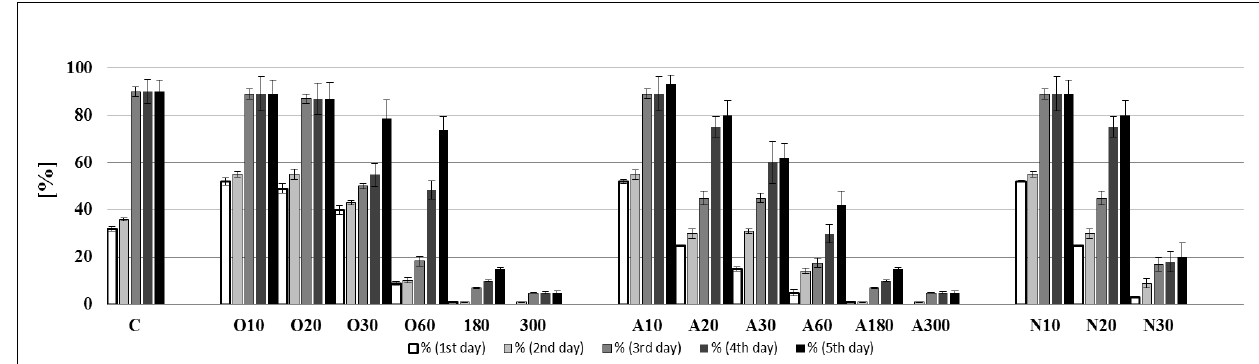
Figure 2. The dynamics of barley grain germination represented by calculated Percentage of Germination (%) on 1st, 2nd, 3rd, 4th and 5th day of cultivation. Variants: C—control/untreated barley grains; O10–O300: barley grains treated with plasma generated in an oxygen atmosphere for 10, 20, 30, 60, 180 or 300 s; A10–A300: barley grains treated with plasma generated in ambient air for 10, 20, 30, 60, 180 or 300 s; N10–N300 barley grains treated with plasma generated in a nitrogen atmosphere for 10, 20, 30, 60, 180 or 300 s. Bars are means of ten experimental runs (one run represents 50 grains per variant, n = 500) ± SD. Table 1. Shoot and root length/weight and adventitious root number of 5-day-old barley seedlings after CAPP treatment. CAPP Application